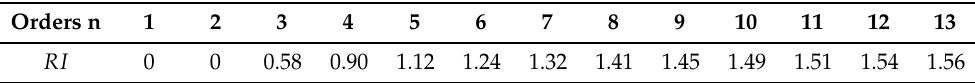
Table 3. Table of Random Consistency Indicator RI Values. Orders